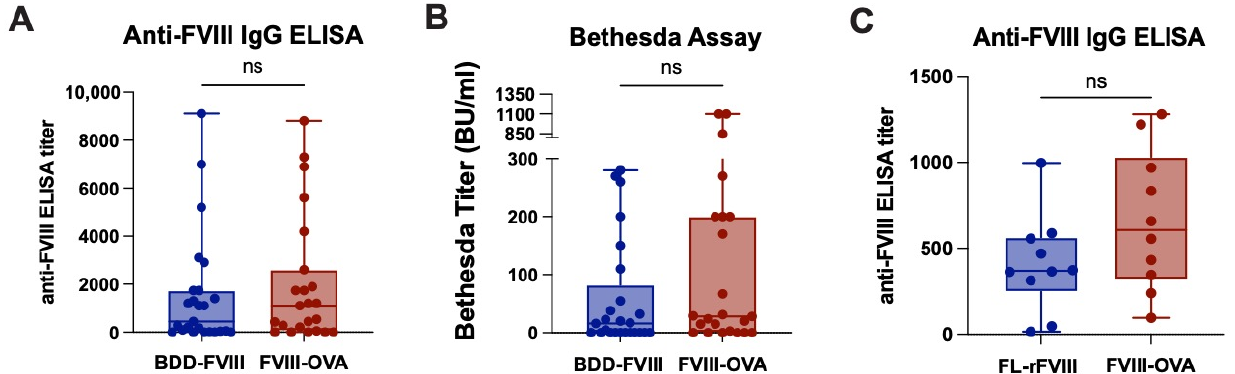
Figure 3. FVIII-OVA is immunogenic in mice with hemophilia A. Hemophilia A mice received weekly (molar equivalent) doses of BDD-FVIII, FL-rFVIII or FVIII-OVA. Plasma was collected one week after the final injection and was evaluated for anti-FVIII IgG by ELISA ( A , C ) and for inhibitors by Bethesda assay ( B ). Statistics were generated using a Mann–Whitney U test. Error bars indicate standard deviation. Horizontal lines represent mean of each group. ns = not significant.